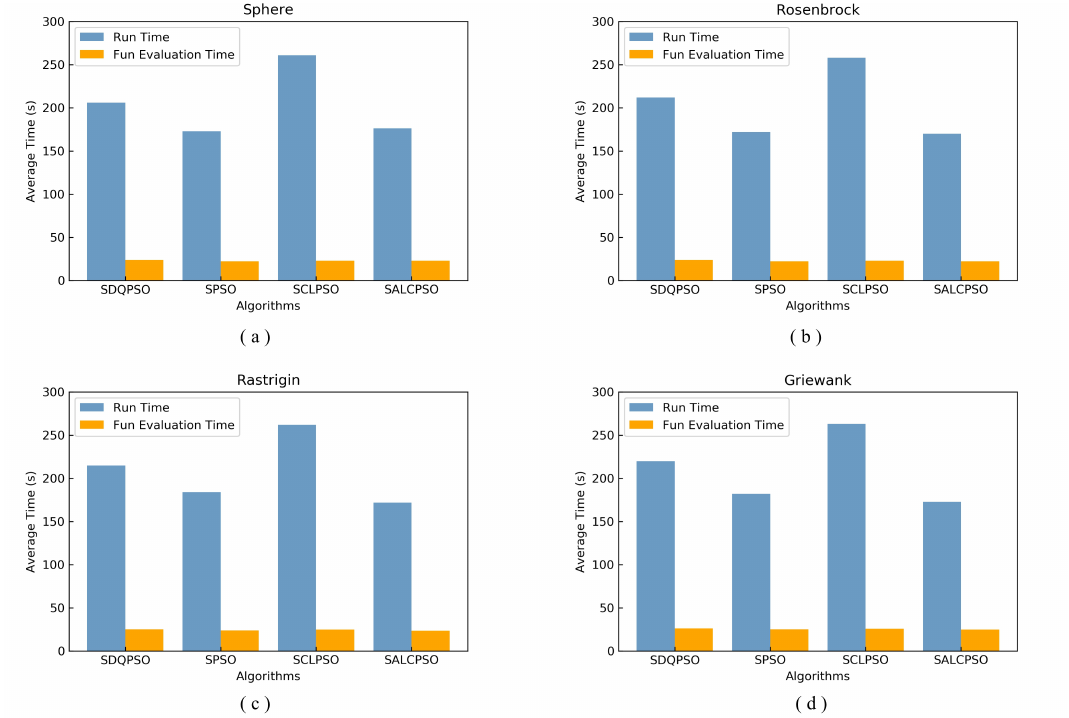
Figure 5. The time metrics on Sphere, Rosenbrock, Rastrigin, Griewank. ( a ) Time on Sphere, ( b ) time on Rosenbrock, ( c ) time on Rastrigin, ( d ) time on Griewank.